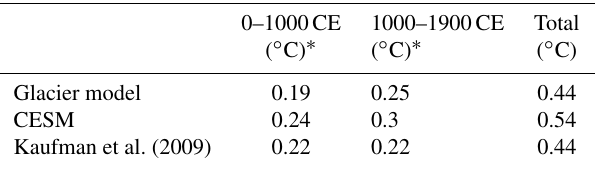
Table 2. Comparison of modeled and observation temperature changes in the Canadian Arctic over the past